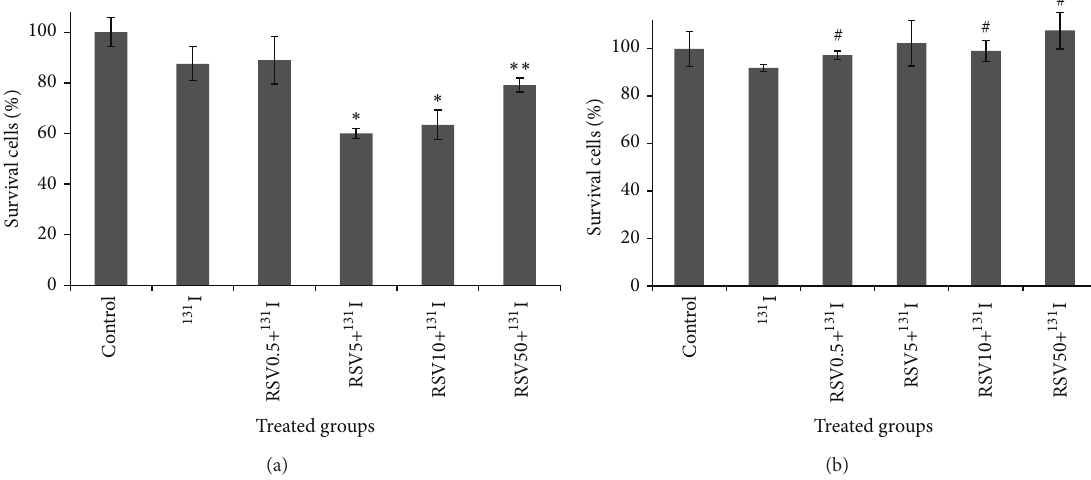
Figure 2: Effect of resveratrol (RSV) at different concentrations (0.5, 5, 10, and 50 𝜇 g/mL) in combination with 131 I on thyroid cancer cells (a) and nonmalignant fibroblast cell (HFFF2) (b). Cell proliferation was assayed with MTT test ( 𝑛 = 4 ). ∗ 𝑃 < 0.05 , comparing RSV5 and RSV10 with 131 I. ∗∗ Nonsignificant, comparing RSV50 and 131 I. # 𝑃 < 0.05 , comparing RSV0.5, 10, and 50 with 131